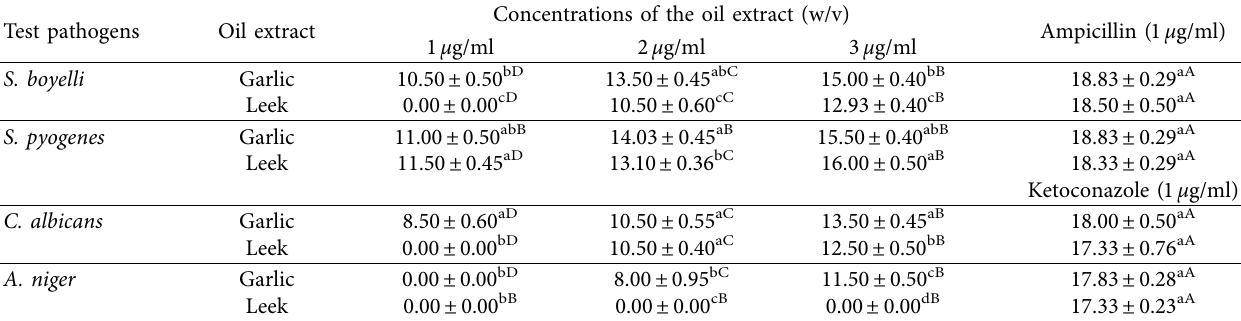
Table 3: Antimicrobial activities oil extracts from garlic bulb and leek leaf oil extracts as mean diameter of zone of inhibition against test pathogenic microbial spp.